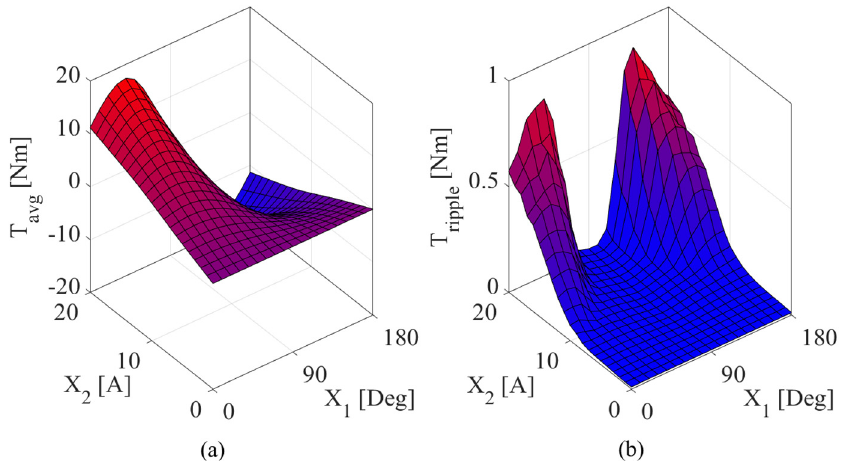
Figure 13. FEA results for torque performance of the Model-IV: ( a ) Average Torque, and ( b ) Torque Ripple.